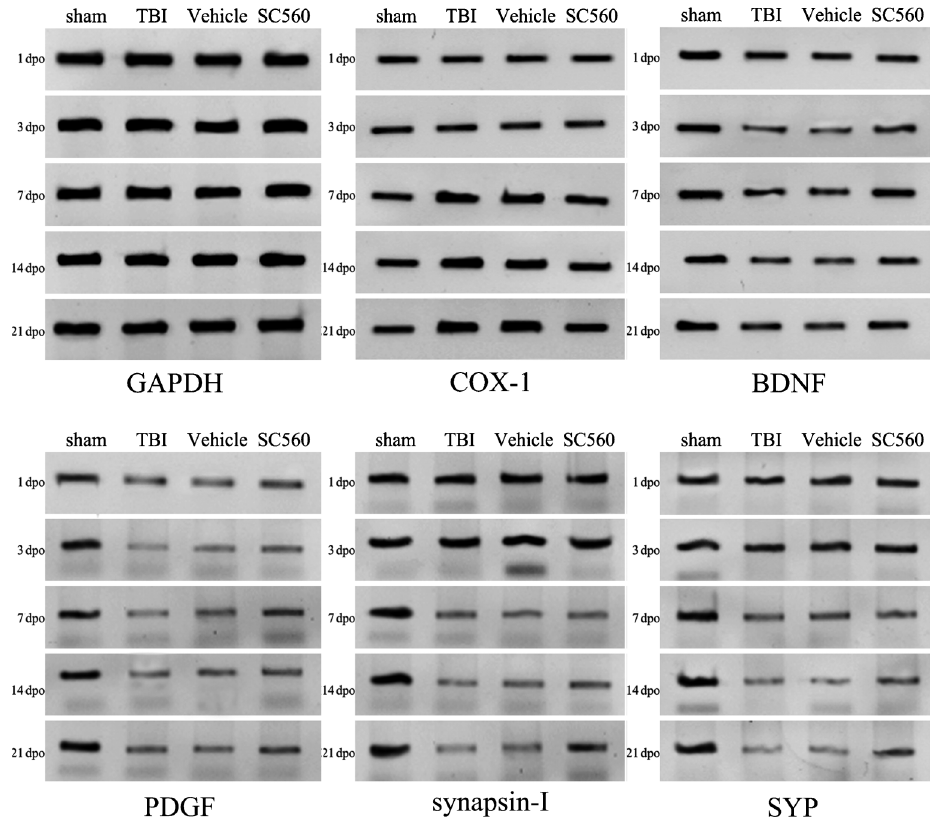
Figure4. Hippocampal expressionsofmultiple proteinsdetectedbyWesternblotting. GAPDH wasusedasthecontrol.TBI:traumaticbrain injury; BDNF: brain-derived neurotrophic factor; PDGF: platelet-derived growth factor BB; SYP: synaptophysin; dpo: days post